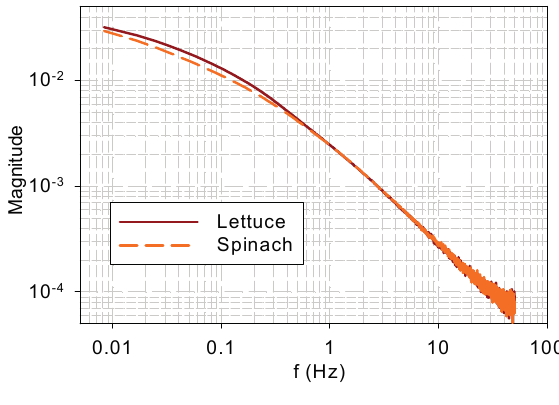
Figure 4. DF spectra of lettuce and spinach samples.